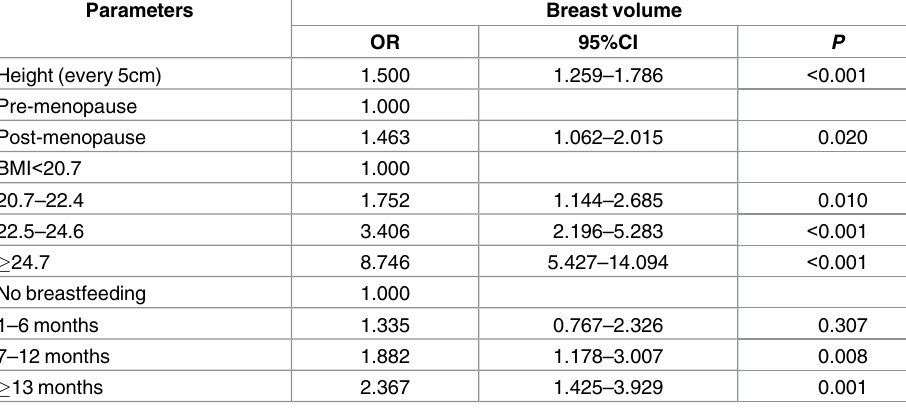
Table 3. Multivariate ordinal logistic regression analysis for breast